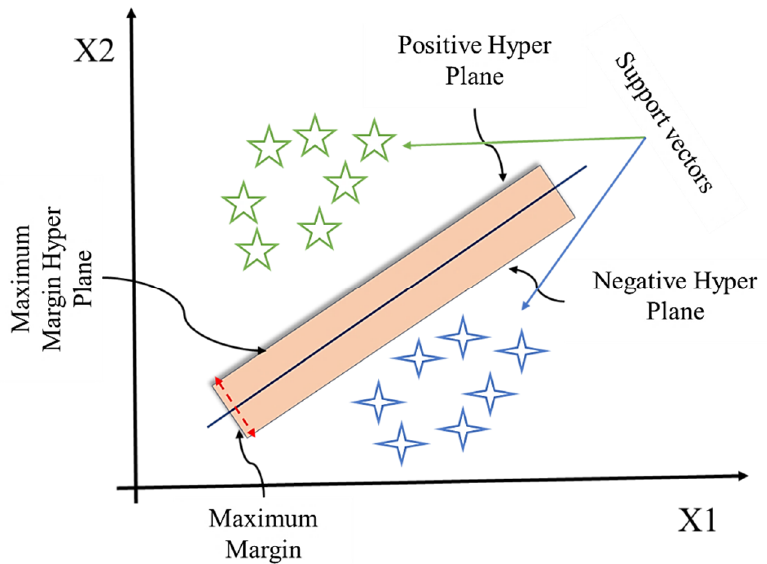
Figure 3. Basic structure of SVM